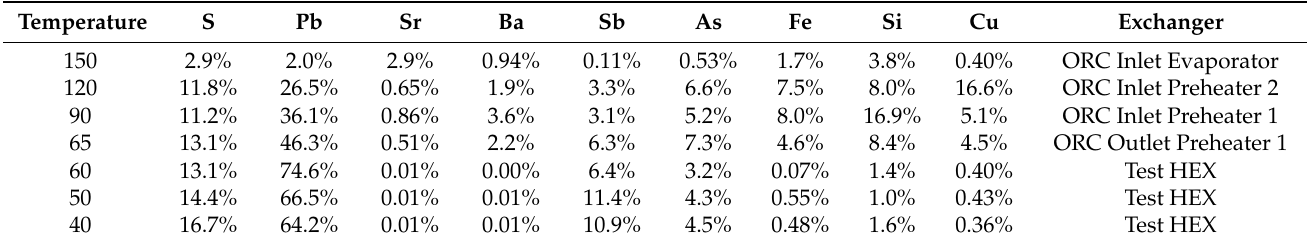
Figure 5. Schematic drawing of the geothermal loop at SsF. Table 3. The mass composition of scales formed in the heat exchangers at the geothermal plant and in the test heat exchangers in